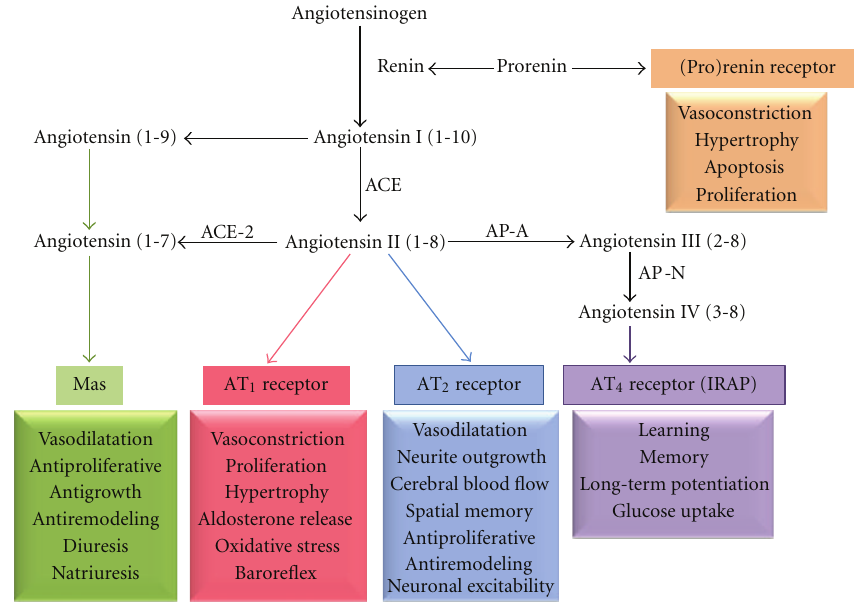
Figure 1: Summary of the brain renin angiotensin system (RAS). The figure summarizes the conversion of angiotensinogen to angiotensins I and II through fragments. The biologically active forms include angiotensins II, III, IV, and (1–7). The main enzymatic pathways are mediated by renin and angiotensin converting enzyme ACE or ACE2, AP-N and AP-A. The major brain e ff ects of angiotensins are mediated by AT 1 , AT 2 , AT 4 , prorenin, and Mas receptors. The functions associated with each receptor are indicated. ACE: angiotensin converting enzyme; AP-A: aminopeptidase A; AP-N: aminopeptidase N, adapted from Phillips and Oliveira, 2008 [3] and from Wright and Harding, 2012